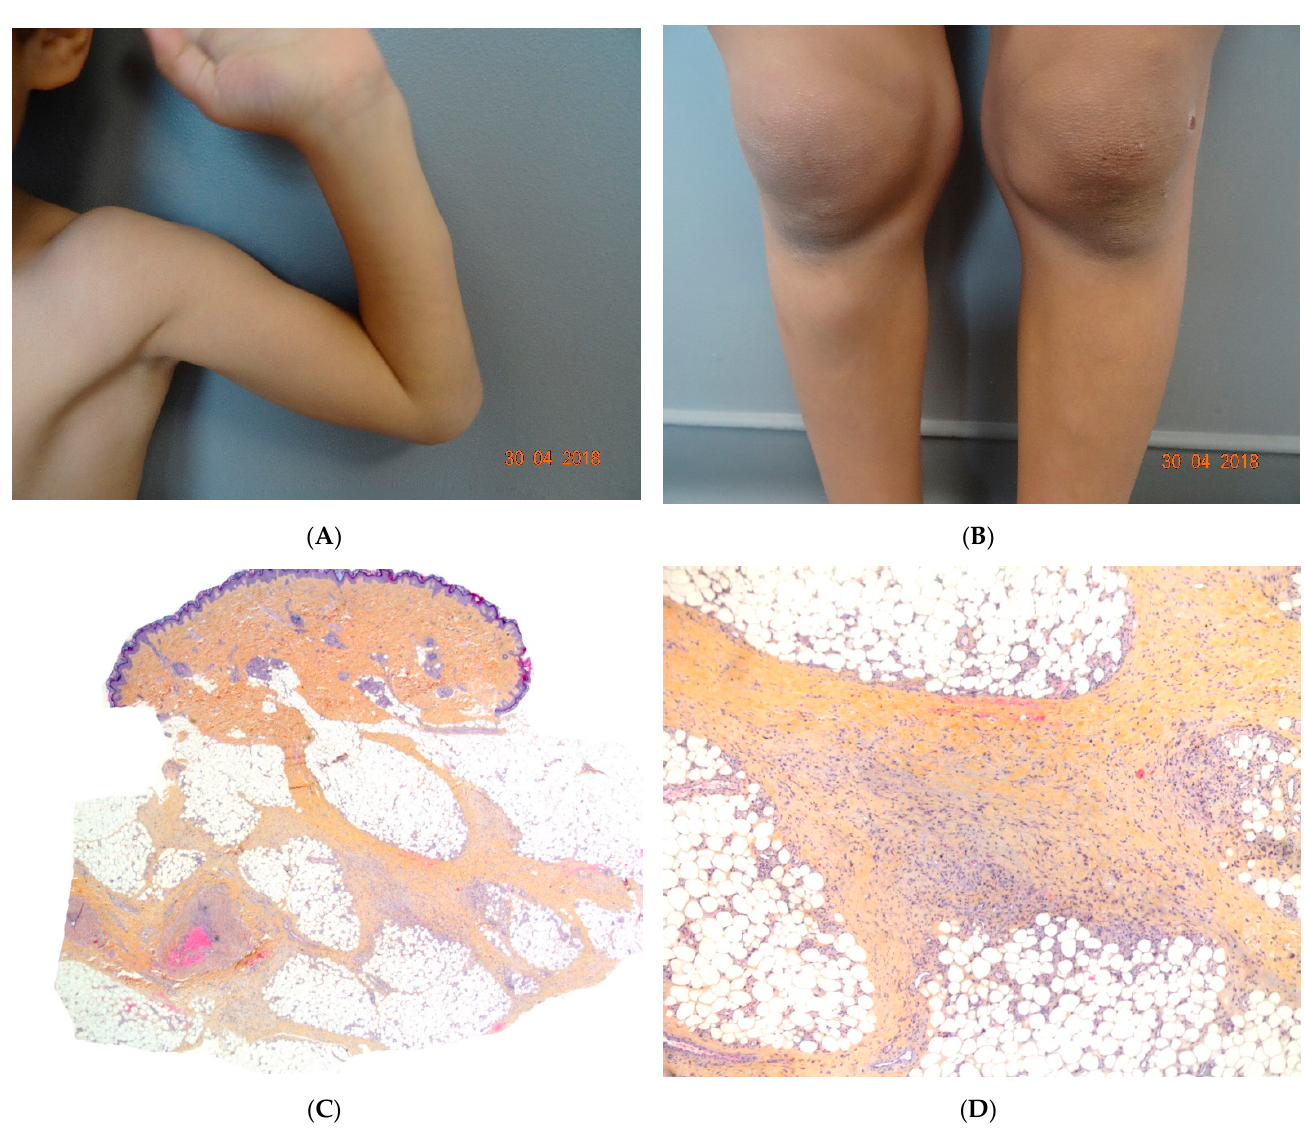
Figure 6. ( A , B ) Self-healing juvenile cutaneous mucinosis. Painful nodules of the limbs. Photo Courtesy of Christine Bodemer Dermatology Department Hopital Necker Enfants Malades. Paris France . ( C , D ) Chronic lobular panniculitis with features of proliferative fasciitis. ( C ) Original magnification ×20, ( D ) original magnification ×100.